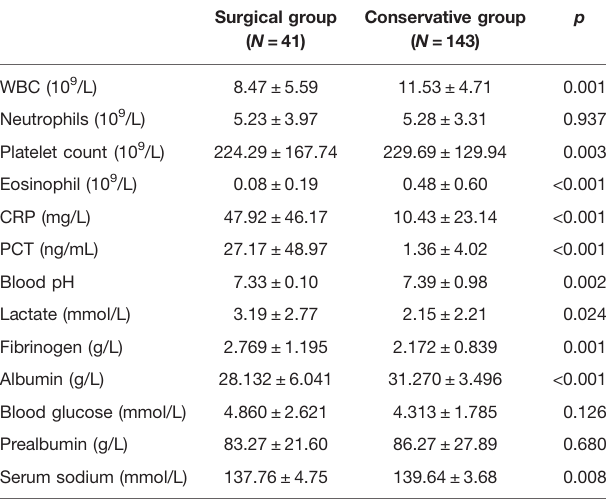
TABLE 2 | Comparisons of laboratory variables between the surgical group and the conservative group.